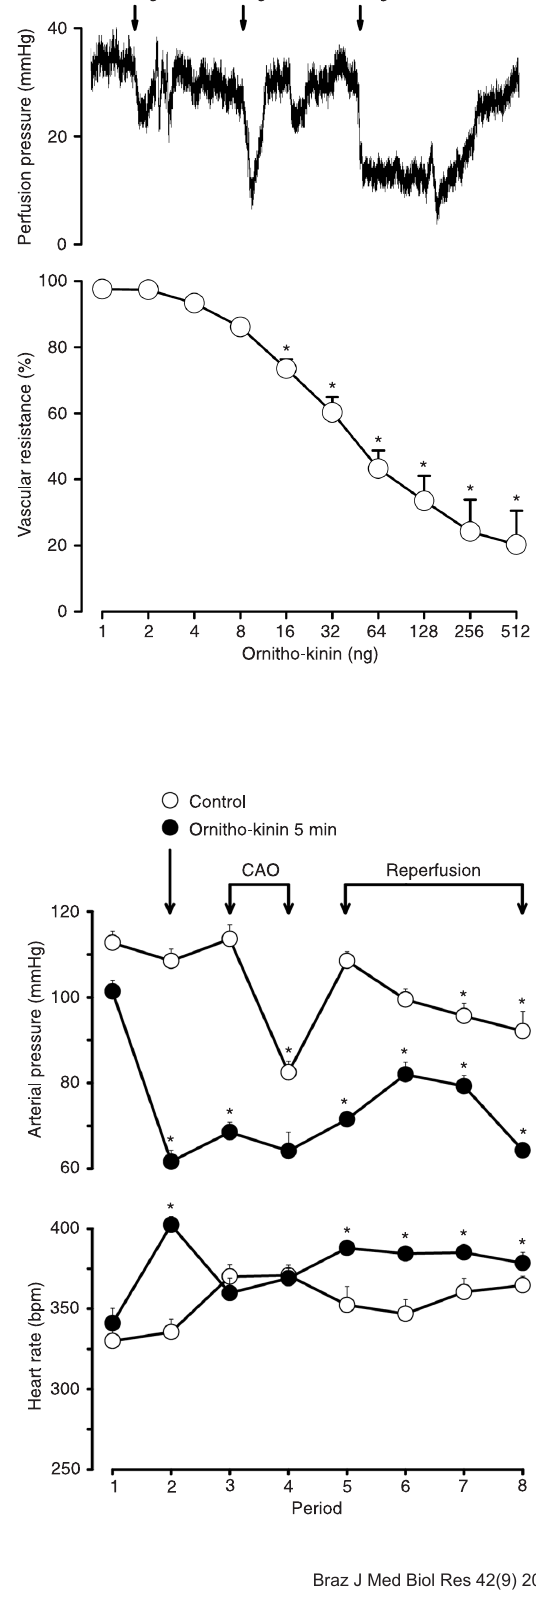
Figure 2. Effect of bolus injections of ornitho-kinin on coronary vascular resistance. The peptide was introduced into the per- fusion medium as it entered the heart. Data are reported as means ± SEM for 6 animals each dose. * P < 0.05 vs no injec- tion (ANOVA followed by the paired t -test).